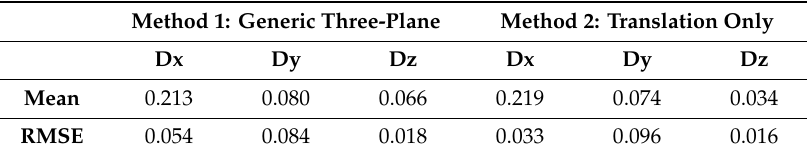
Table 5. 3D absolute error statistics in